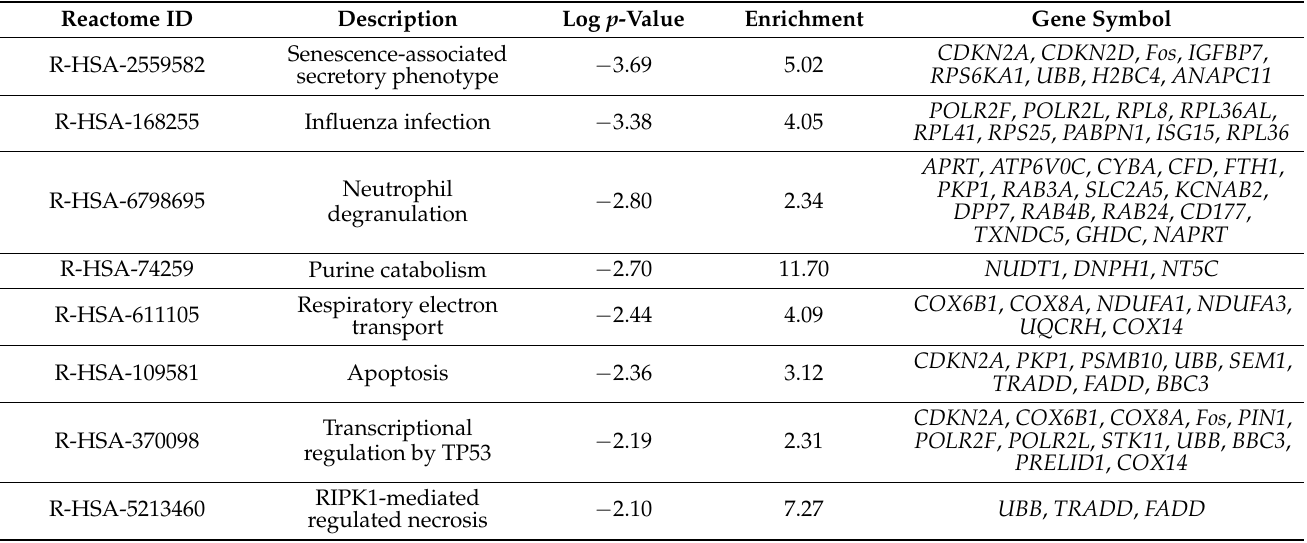
Table 3. Reactome analysis of low-dose UVA-related differentially expressed genes.